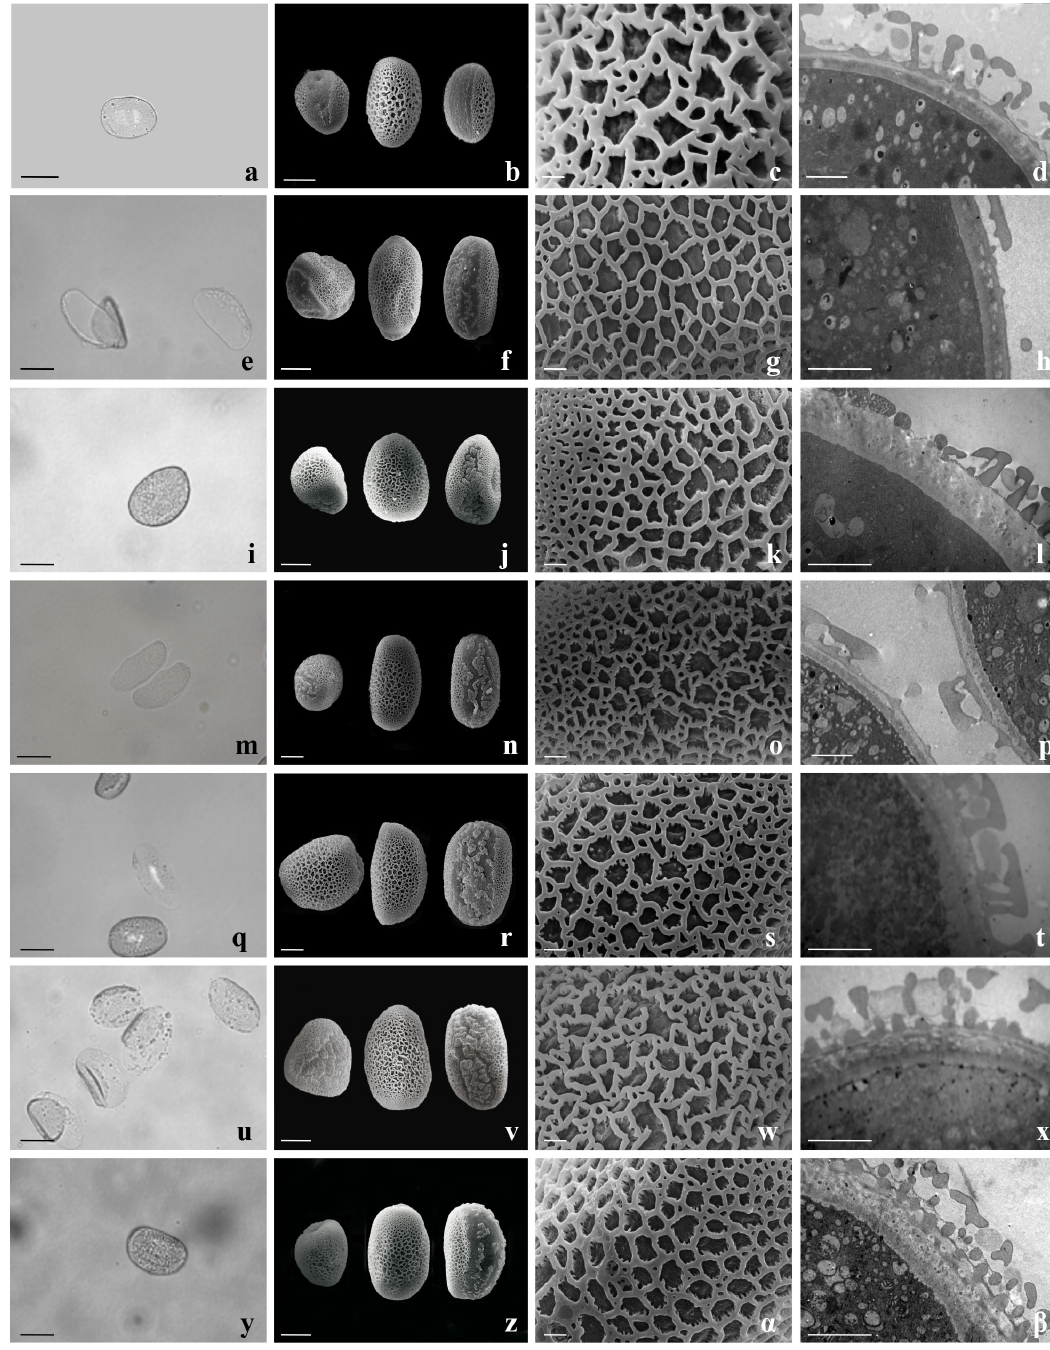
Figure 3 - Morphology and exine characteristics of Alcantarea nahoumii and Vriesea pollen grains. a-d ) Al. nahoumii ; e-h ) V. carinata ; i-l ) V. friburgensis ; m-p ) V. michaelii ; q-t ) V. paraibica ; u-x ) V. simplex; y-z-α-ß ) V. unilateralis ; a, e, i, m, q, u, y ) pollen after lactic acetolysis; b, f, j, n, r, v, z ) polar and equatorial view; c, g, k, o, s, w, α ) detail of the ornamentation of the exine; d, h, l, p, t, x, ß ) detail of grain wall; a, e, i, m, q, u, y ) images obtained by light microscopy, lactic acetolysis; b, c, f, g, j, k, n, o, r, s, v, w, z, α ) scanning electron microscopy; d, h, l, p, t, x, ß ) transmission electronic microscopy. Bars: a, e, i, m, q, u, y = 50 µm; b, f, j, n, r, v, z = 20 µm; c, d, g, h, k, l, o, p, s, t, w, x, α , ß = 2